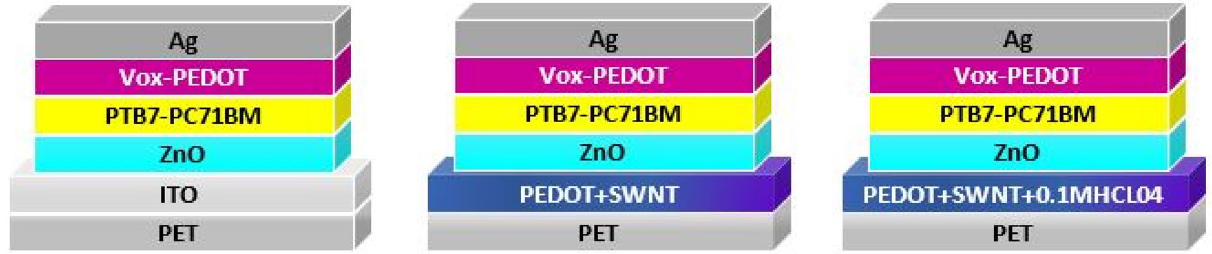
Figure 1. Schematic device structure based on PET/PEDOT-SWCNT, PET/PEDOT-SWCNT + (0.1 M) HClO 4 and ITO